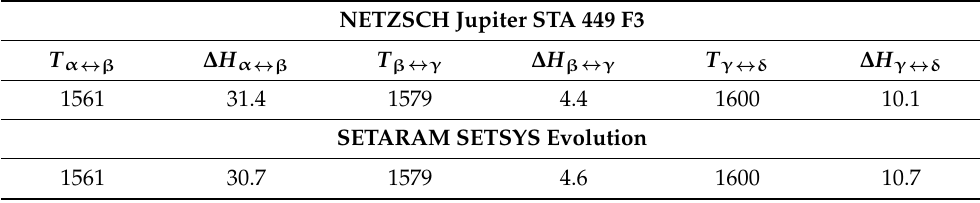
Figure 9. Dependences of temperature and (incongruent, congruent) melting enthalpy values of known ALnCuX 3 (A = Eu, Sr, Ba), (X = S, Se) on the ionic radius of Ln +3 cations. Table 4. Temperature (K) and phase transition enthalpy (kJ mol 1 ) values in the EuErCuSe 3